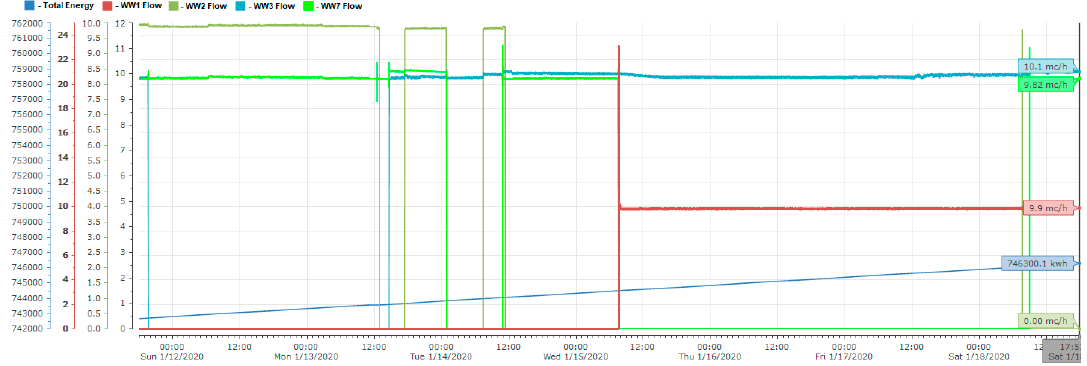
Figure 12. Results with constrained FDC. Well flows (mc/h) and energy consumption (kWh) in Week 2 of tests.